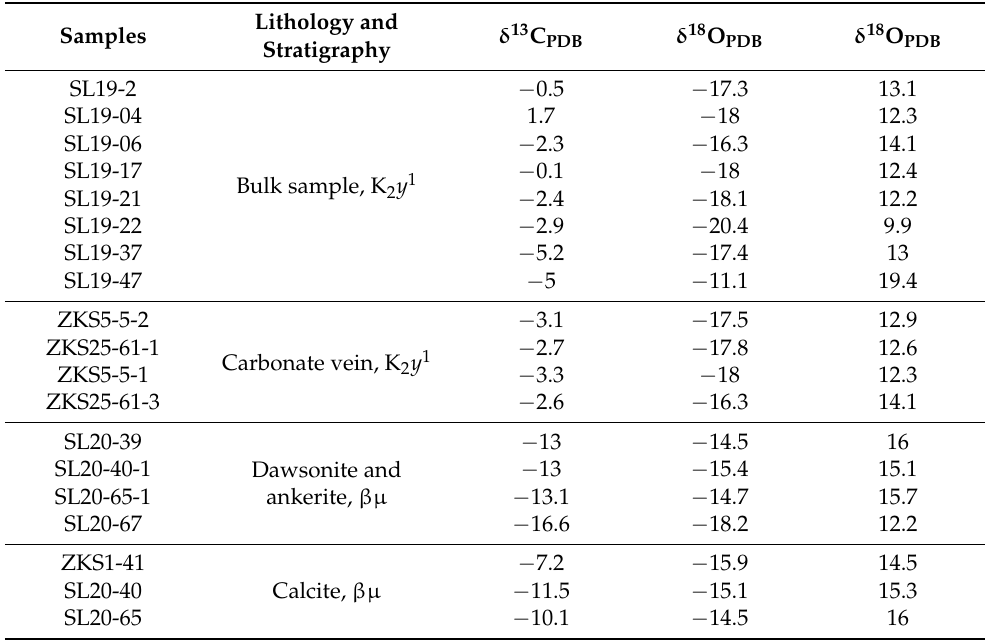
Table 2. C and O isotopic compositions of carbonate from dolerite and altered sandstone in the Lower member of Yaojia Formation.